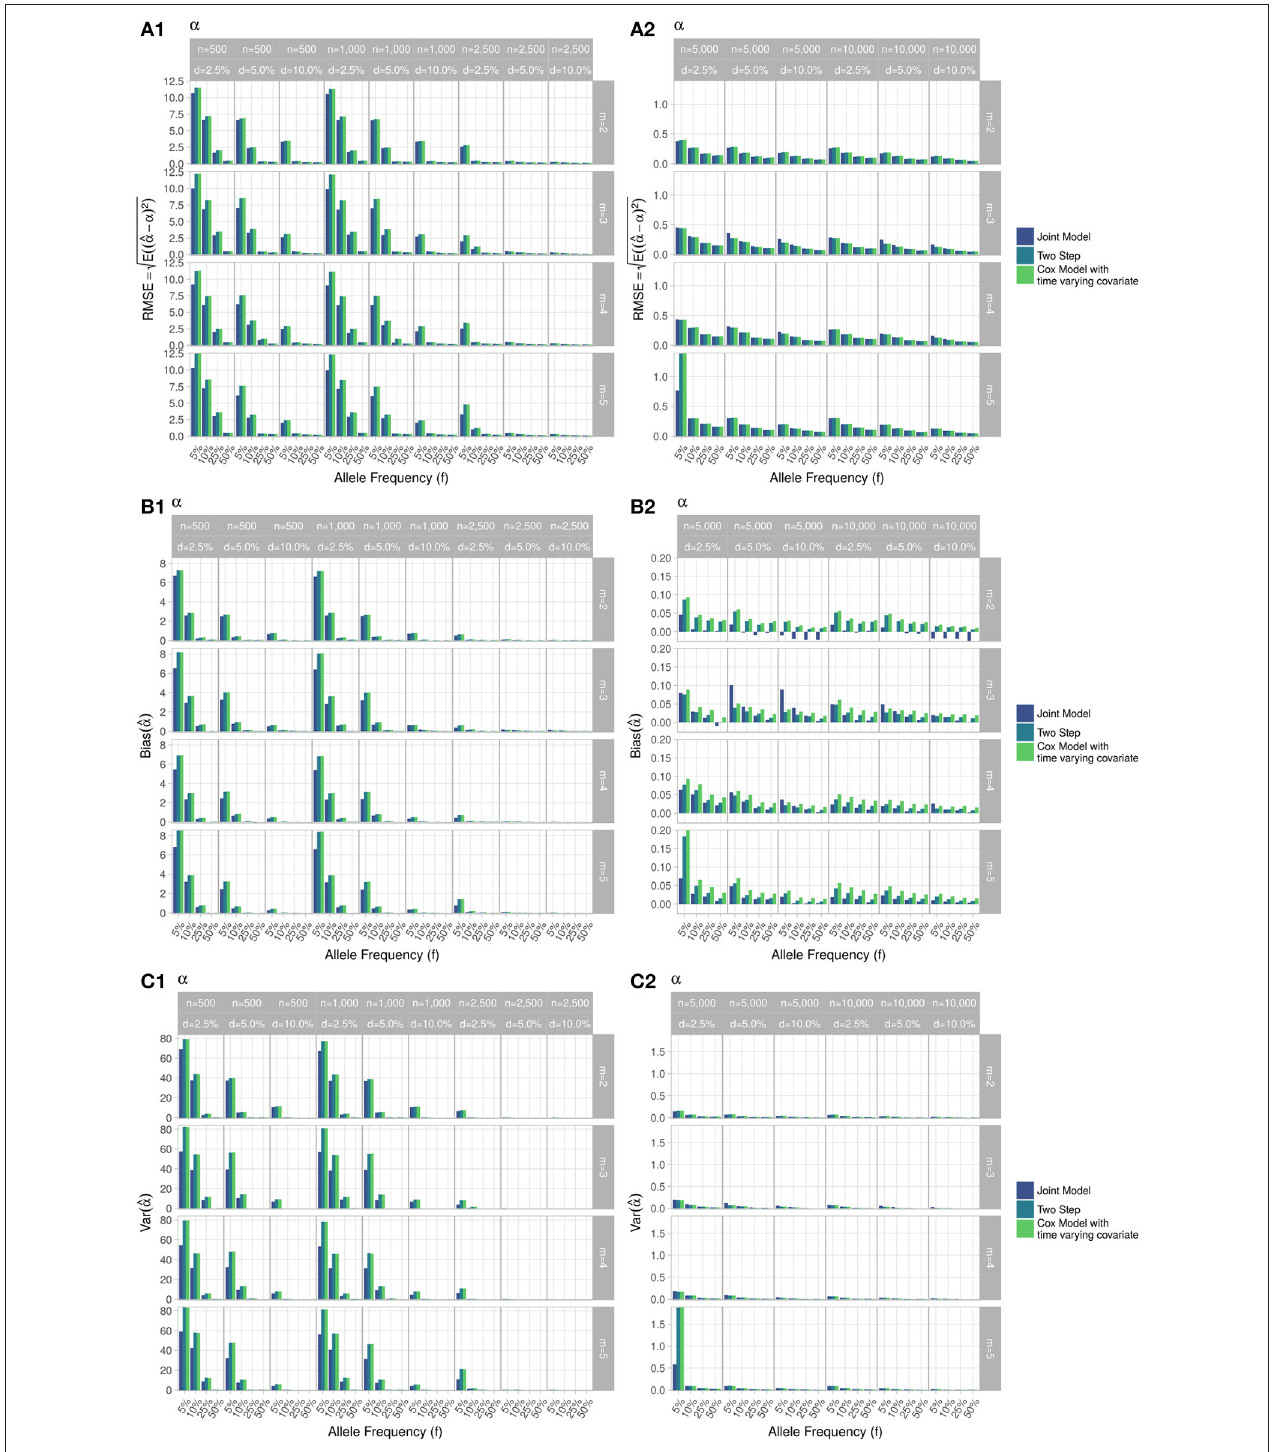
FIGURE 5 | Simulation study for accuracy of estimator ˆ α provided by the joint model (“JM” package), by the two-step linear mixed effect model (“nlme” package) and by the Cox model with time-varying covariate. m , number of measures; n , number of individuals; d , diabetes incidence rate. (A) Displays RMSE, (B) Displays bias and (C) Displays variance. (1) Displays results for n = 500 to n = 2,500. (2) Displays results for n = 5,000 to n = 10,000.